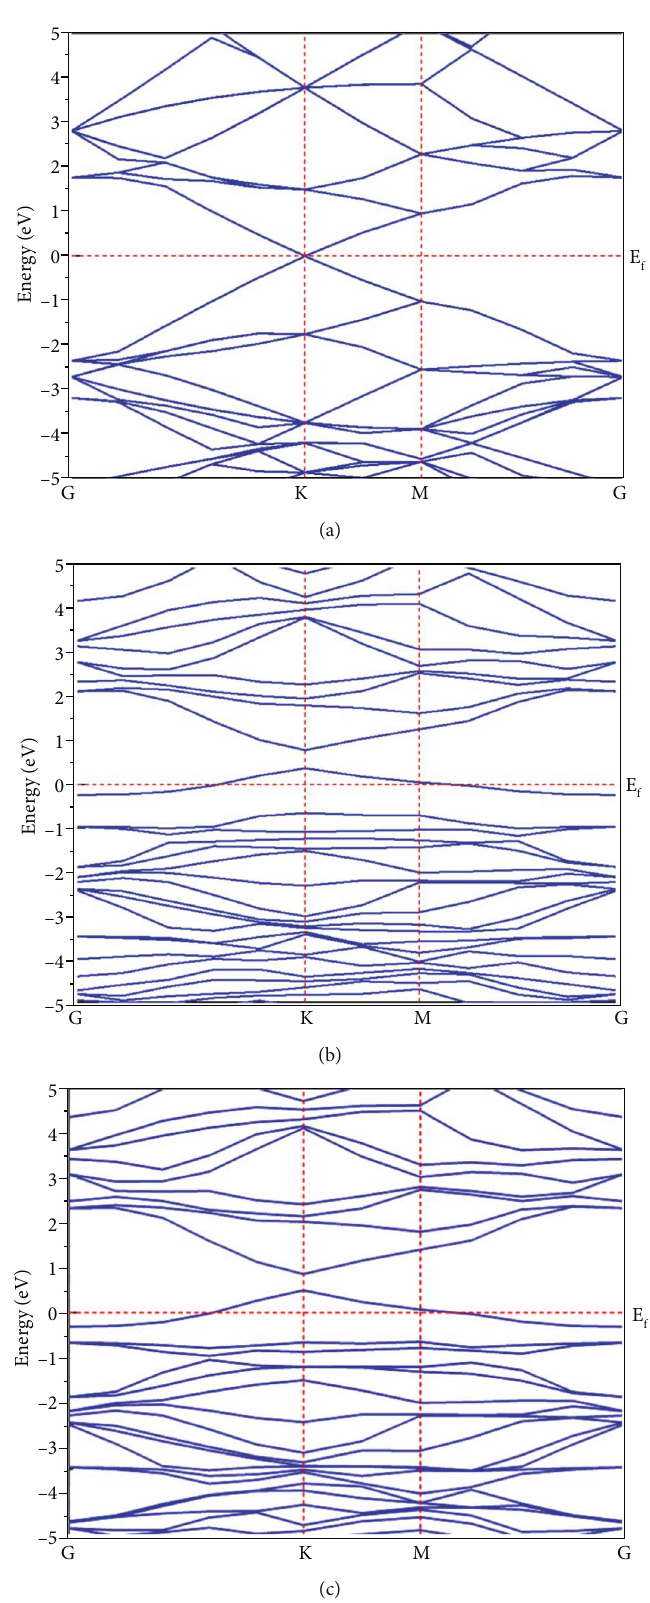
Figure 3: The band structure of undoped graphene, Al- and Ga-Graphene ((a) Undoped Graphene; (b) Al-Graphene; (c)